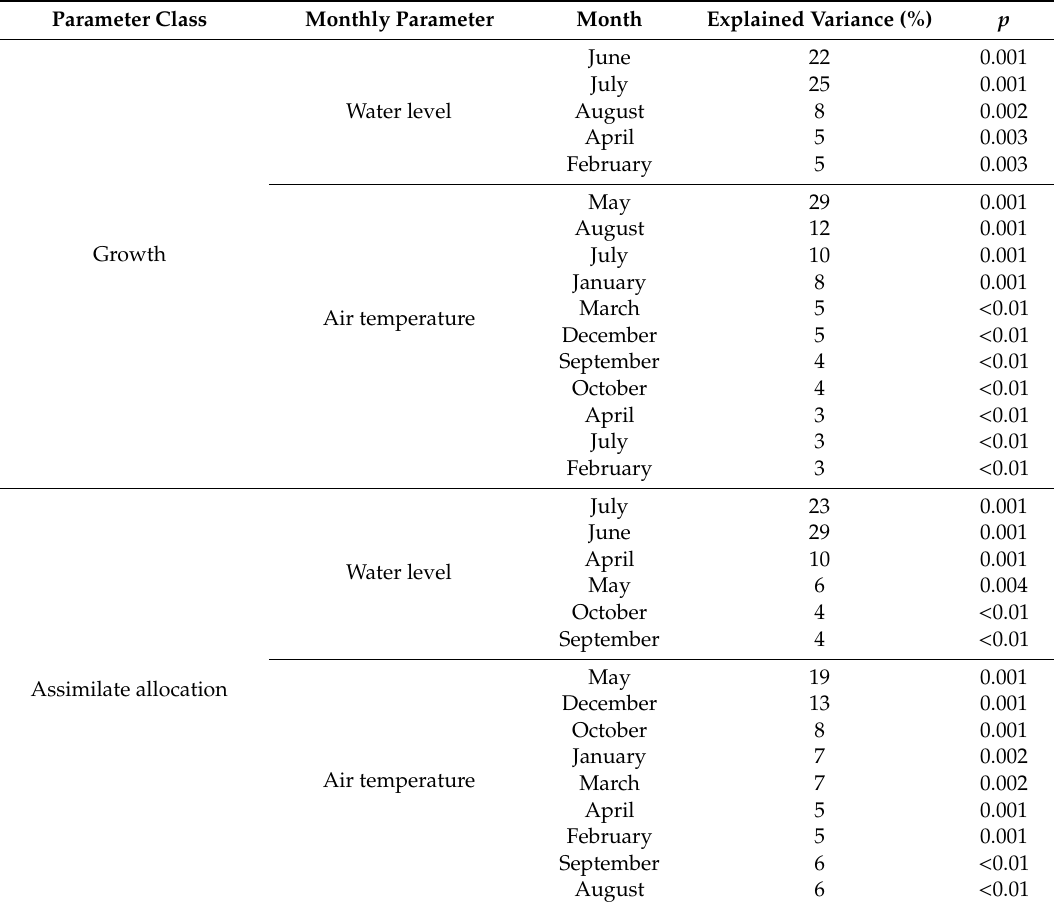
Table 4. Redundancy analysis for the significant explained variance for the growth and assimilate allocation parameters for the lake reed stand (Zadnji Kraj), as defined by the monthly water levels and air